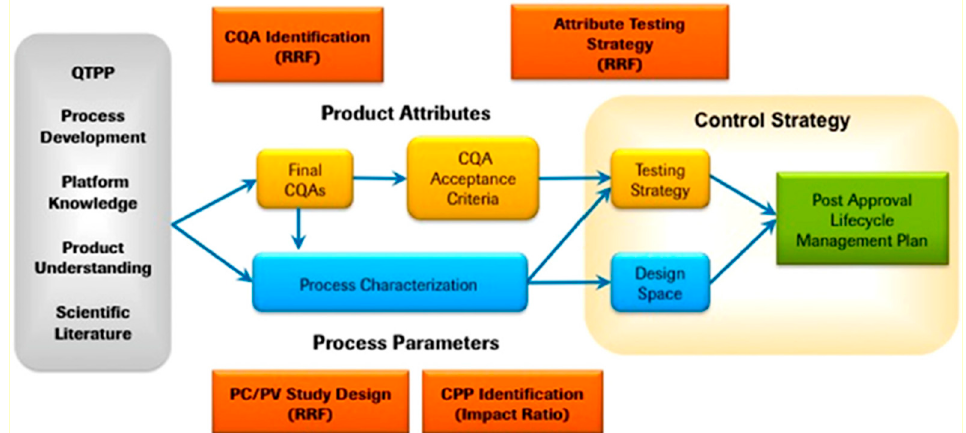
Figure 4. Example of Quality by Design process steps in coordinated decision-making framework for manufacturing of biopharmaceuticals. PC/PV = process characterization and process validation; RRF = risk ranking and filtering tool. Reprinted from [82] with permission from Elsevier.